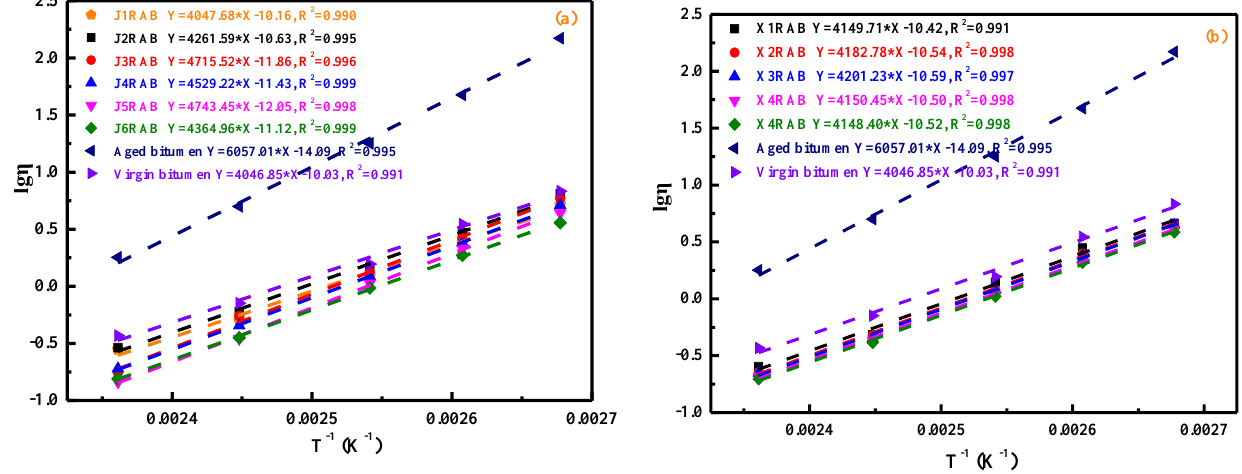
Figure 6. The correlation of viscosity and temperature for aged and rejuvenated bitumen. The viscosity-temperature correlation equations of the virgin, aged, and rejuvenated binders are also shown in Figure 6, and the slope value represents the temperature sen- sitivity [22]. It is demonstrated that the aged bitumen exhibits the highest slope value, indicating that its temperature susceptibility is strongest. Meanwhile, virgin